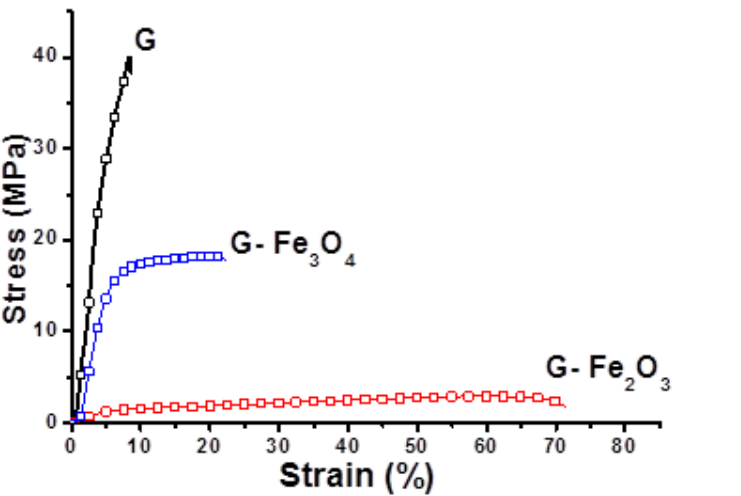
Figure 5. Variation of the mechanical properties at room temperature for all studied materials. Table 2. Main mechanical properties for the studied